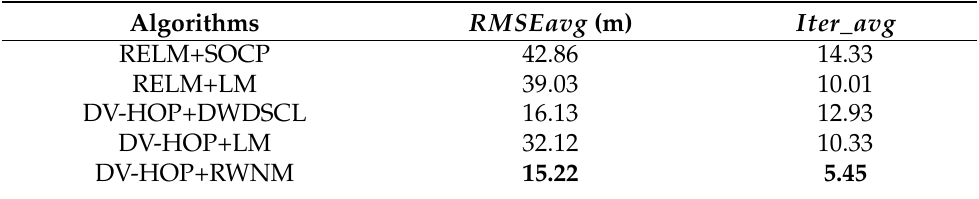
Table 5. RMSEavg and Iter _ avg at different outliers values using R = 45 m and nfe = 0.3, the best performances in RMSE average and iteration average are denoted in bold